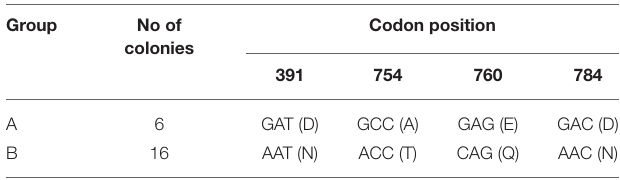
TABLE 3 | Nucleotide and amino acid changes in the rpsA gene of a total of 22 colonies (the initial four colonies and the subsequent 18 colonies). Group No of